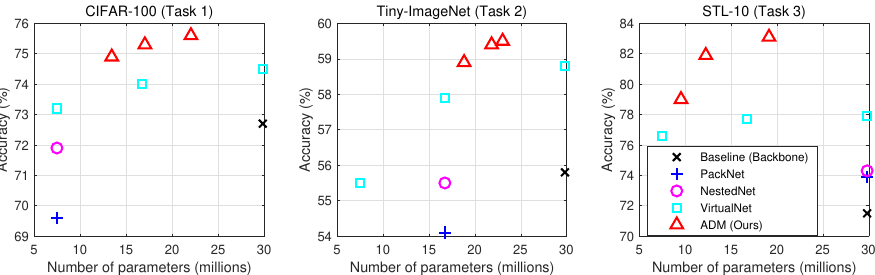
Figure 5. Classification results of the multi-task learning problem using three datasets (three tasks): CIFAR-100, Tiny-ImageNet, and STL-10. All the methods are based on ResNet-42 (29.8 million parameters).